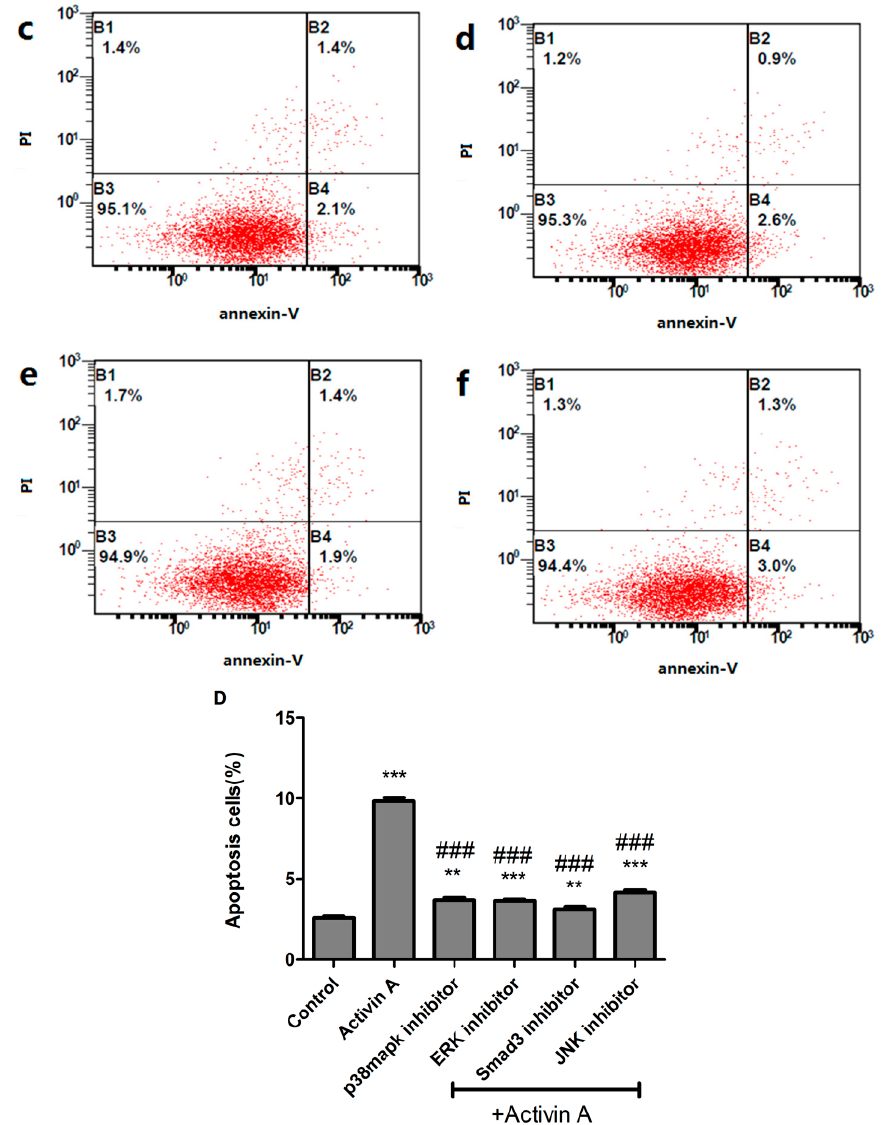
Figure 6. Expression levels of follistatin and endoplasmic reticulum stress (ERS)-related molecules in activin A-stimulated H9c2 cells. ( A ) Western blot was performed to test the expression of follistatin and ERS-related molecules. Proteins were extracted from H9c2 cells, separated by sodium dodecyl sulfate–polyacrylamide gel electrophoresis, and immunoblotted sequentially with antibodies. (1) Control, (2) activin A (100 ng/mL), (3) activin A (100 ng/mL) + p38MAPK inhibitor, (4) activin A (100 ng/mL) + ERK inhibitor, (5) activin A (100 ng/mL) + Smad3 inhibitor, (6) activin A (100 ng/mL) + JNK inhibitor; ( B ) The graph showed the result of densitometric quantification of proteins relative to GAPDH as an internal control. ( a ) CHOP, ( b ) caspase-12, ( c ) GRP-78, ( d ) Follistatin; ( C ) H9c2 cells were stained with PI and Annexin V-FITC and sorted by fluorescence-activated flow cytometry. ( a ) Control, ( b ) activin A (100 ng/mL), ( c ) activin A (100 ng/mL) + p38MAPK inhibitor, ( d ) activin A (100 ng/mL) + ERK inhibitor, ( e ) activin A (100 ng/mL) + Smad3 inhibitor, ( f ) activin A (100 ng/mL) + JNK inhibitor; ( D ) Graph presented the apoptotic rate of H9c2 cells. The data are presented as the mean ± standard deviation. ** p < 0.01, *** p < 0.001 versus the control group; ## p < 0.01, ### p < 0.001 versus the activin A group.